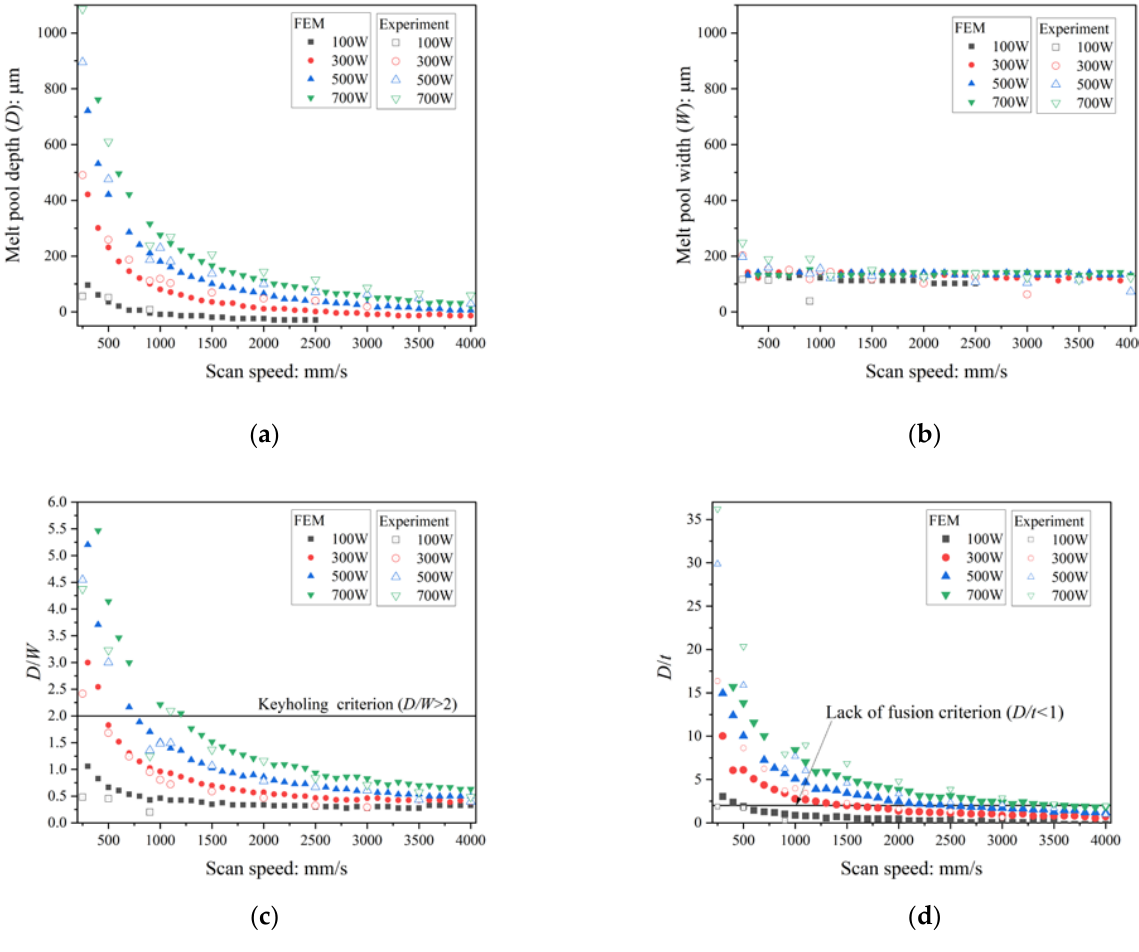
Figure 6. Comparison of melt pool depth: D ( a ), width: W ( b ), D / W ( c ), and D / t ( d ) between the single-track experiments and FEM simulations.